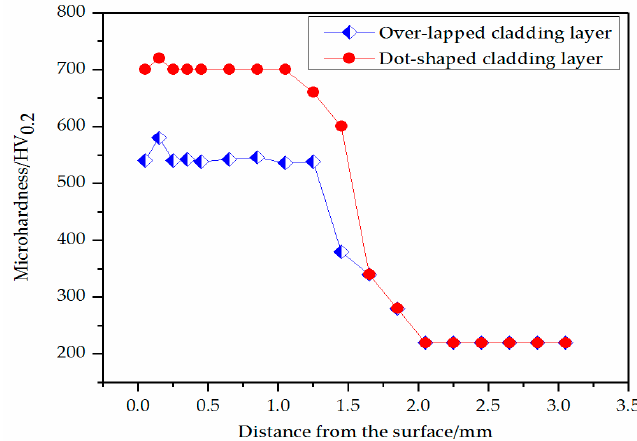
Figure 7. Hardness distribution of the two cladding layers along the depth direction.